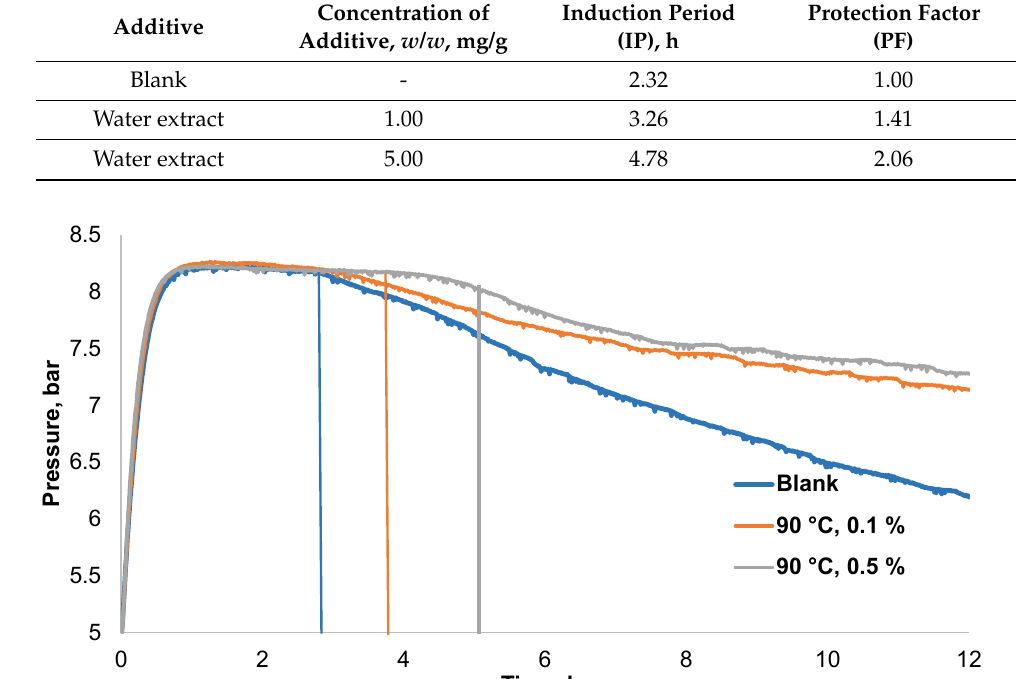
9 of 15 Figure 8. Correlations between antioxidant activity tests and total polyphenol content. ( A ) Sequential extraction with or- ganic solvents at different temperatures ( B ) with one-step and sequential extraction with deionized water at different temperatures.